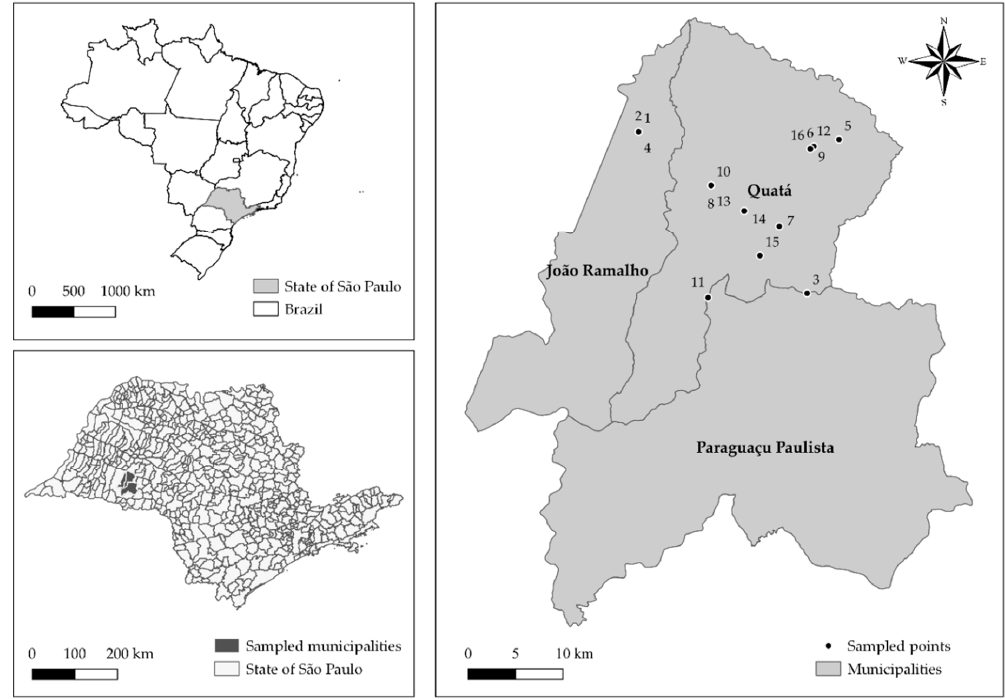
Figure 1. Geographical localization of sugarcane fields (1–16) in the state of São Paulo, Brazil, where roots from adult sugarcane clumps were sampled for the isolation of dark septate endophytes (DSEs). Point georeferences: 1 (22.136289 ◦ S 50.756884 ◦ W), 2 (22.136231 ◦ S 50.756927 ◦ W), 3 (22.302731 ◦ S 50.583676 ◦ W), 4 (22.136308 ◦ S 50.756930 ◦ W), 5 (22.144143 ◦ S 50.550939 ◦ W), 6 (22.153620 ◦ S 50.580430 ◦ W), 7 (22.233203 ◦ S 50.612332 ◦ W), 8 (22.191161 ◦ S 50.682404 ◦ W), 9 (22.153670 ◦ S 50.580390 ◦ W), 10 (22.191110 ◦ S 50.682444 ◦ W), 11 (22.307150 ◦ S 50.685457 ◦ W), 12 (22.151228 ◦ S 50.576790 ◦ W), 13 (22.191096 ◦ S 50.682333 ◦ W), 14 (22.217306 ◦ S 50.648372 ◦ W), 15 (22.264116 ◦ S 50.632208 ◦ W), and 16 (22.153690 ◦ S 50.580440 ◦